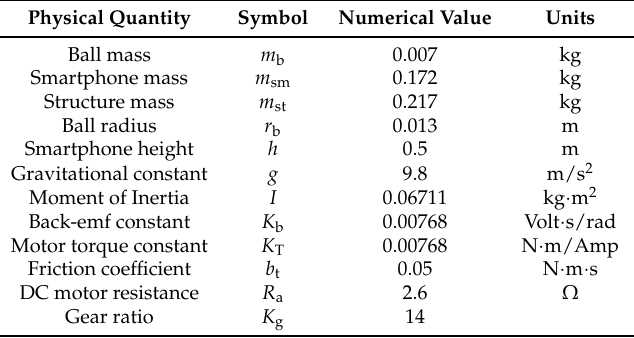
Table 2. Numerical values for physical parameters of the ball and beam test-bed.